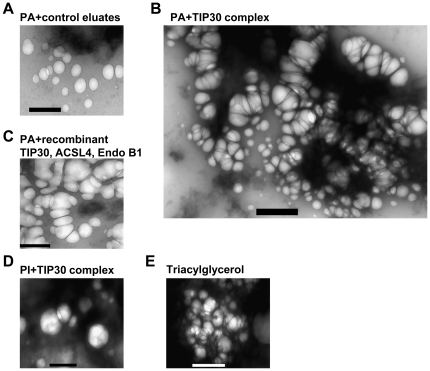
Fatty acylation of phosphatidic acid induce vesicle tethering and stacking.Effects of acylated PA on vesicle fusion were determined using electron microscope. Lipids were extracted after incubating PA with control immunoprecipitates (A), PA with immunopurified TIP30 complex (B), PA with recombinant TIP30, ACSL4, and Endo B1 (C) or PI with immunopurified TIP30 complex (D). Each of these lipids or triacylglycerol (E) was suspended in homogenization buffer and incubated on ice with EGFR-DsRed and EYFP-Rab5a vesicles. The resulting vesicles were examined using TEM. Scale bars, 500 nm.